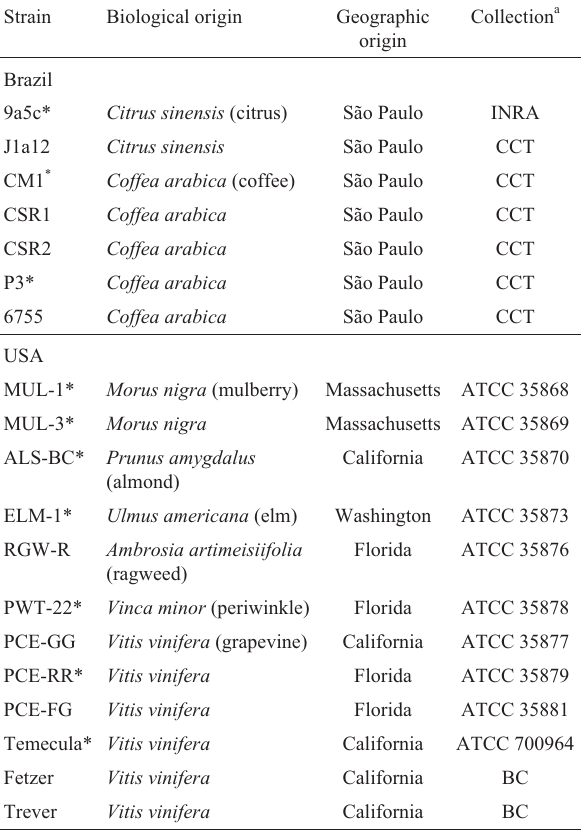
Table 1 - Strains of Xylella fastidiosa used in this study.